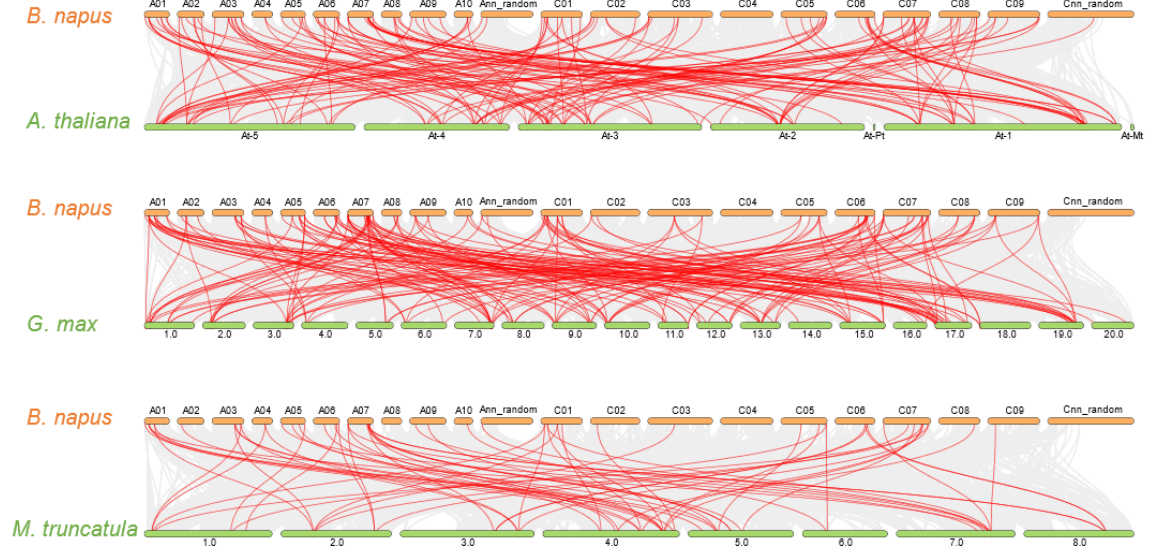
Figure 5. Synteny analysis of the GARP family genes between B. napus and A. thaliana, G. max, and M. truncatula . Gray lines indicate all collinear blocks within B. napus and A. thaliana , G. max, and M. truncatula. while the red lines depict the orthologous relationships.